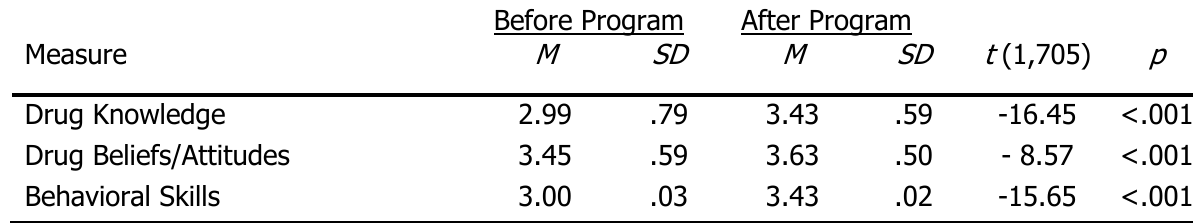
Changes in Knowledge, Attitudes and Skills as a Result of Participating in Health Rocks! Before